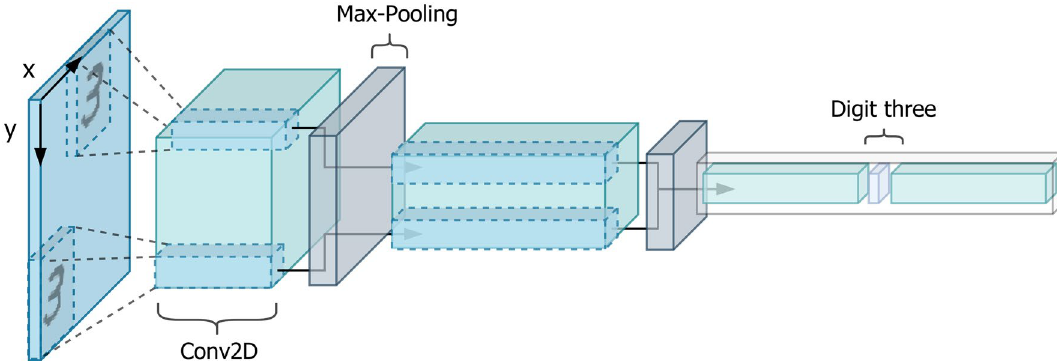
Figure 1. Compressed representation of a simple CNN with max-pooling layers for spatial reduction and two input objects obtained with a plain spatial translation. Max-pooling operations are schematized in such a way that their primitive routing role is highlighted for both digits. Low-level features detected in the earlier stage of the network are progressively routed to common high-level features. So, the model is translation invariant but gradually loses relevant object localization